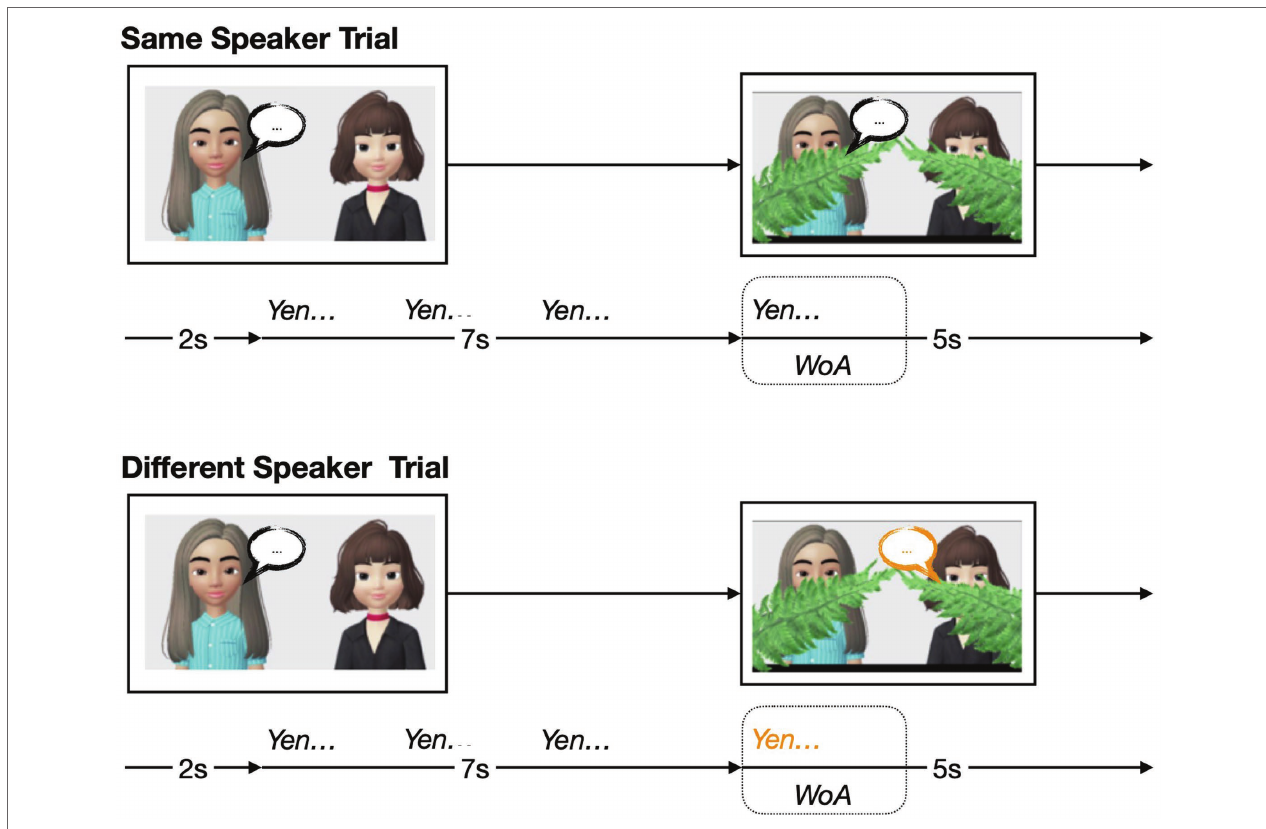
FIGURE 1 | Visual schematic of the two types of trials in the test phase of the experiment: Same Speaker trial, and Different Speaker trial. WoA represents window of analysis (WoA), which was 2 s